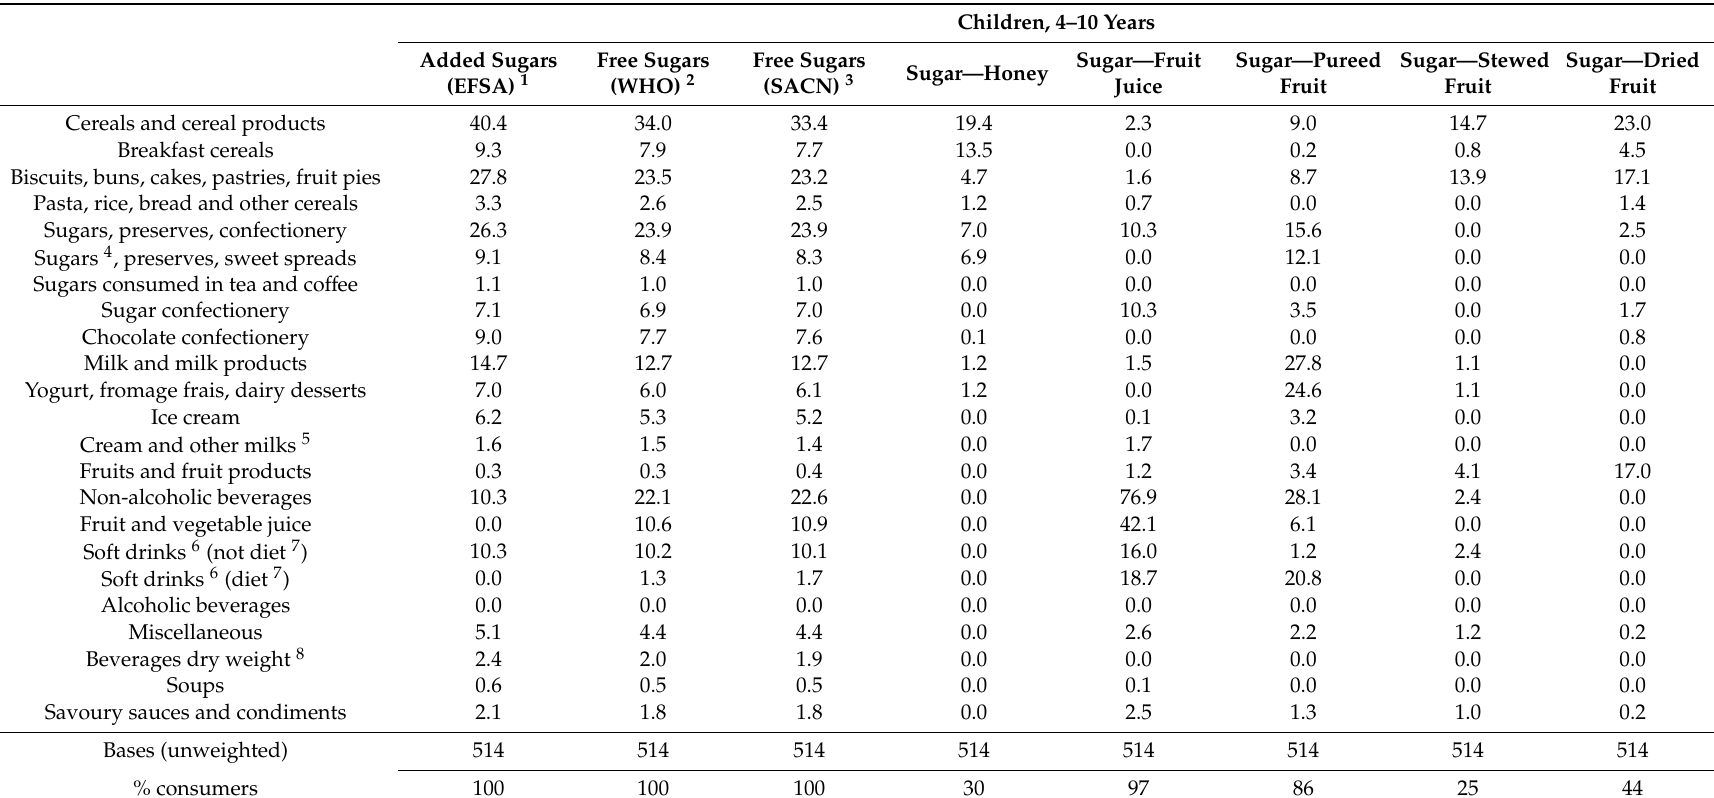
Table 5. Contribution (%) of NDNS RP food group sources to intake of sugars by age (4–10 Years) (NDNS